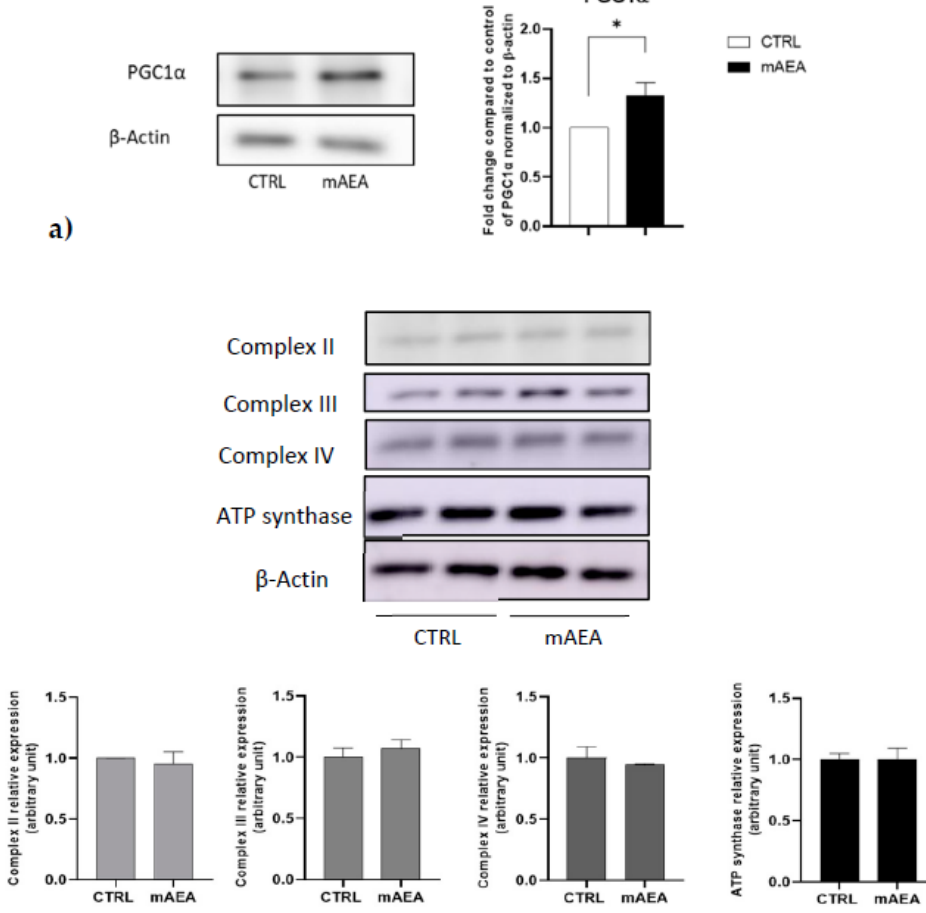
Figure 11. Effect of mAEA on PGC1 α ( a ) and respiratory chain complexes’ ( b ) expression. C2C12 myoblasts were treated with mAEA (5 µ M) for 24 h. Samples were subjected to SDS-PAGE and Western blot analysis using anti-PGC1 α , as well as OXPHOS WB Antibody Cocktail specific for respiratory chain complexes and anti- β -actin antibody as housekeeping. The data were reported after densitometric analysis of the bands as means ± SEM normalized to β -actin of three independent experiments performed in duplicate. Statistical analysis was performed by analysis of variance using Student t -test [* p < 0.05 vs. control cells (CTRL)]. Moreover, the ability of 5 µ M mAEA to affect oxygen consumption was examined by high-resolution respirometry. To this end, C2C12 myoblasts were treated with 5 µ M mAEA for 24 h, then were collected and subjected to basal oxygen consumption (ROUTINE), proton leak (LEAK) and maximal oxygen consumption (E) measurement by the Oroboros- O2K system. At 5 µ M, mAEA was unable to affect any of these respiratory parameters in C2C12 myoblasts (Figure